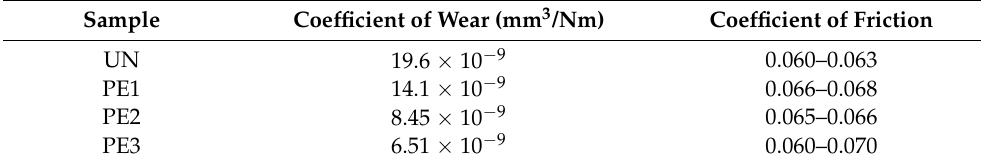
Table 6. Coefficient of wear and friction [117].